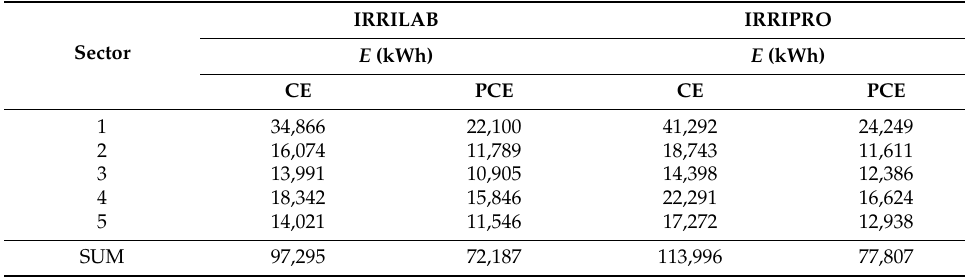
Table 8. Energy, E, required for the micro-irrigation system of the apple farm subdivided in the actual “non-uniform” five sectors, designed by both IRRILAB and IRRIPRO software, for common emitters (CE) and pressure compensating emitters